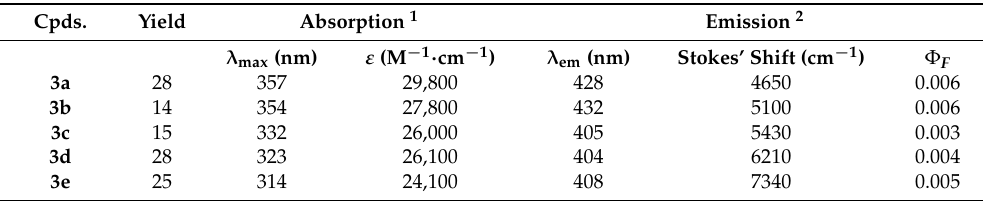
Table 1. Yields, UV-Visible absorption and emission data for thienylpyridazines 3a – e . Cpds.